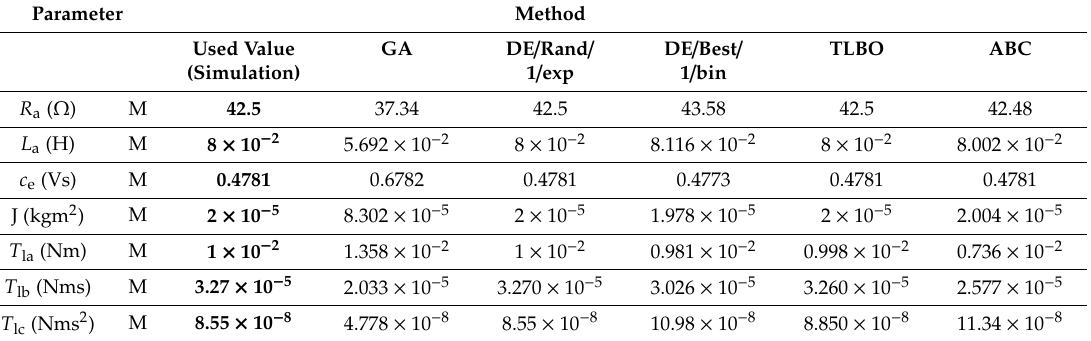
Table 6. Mean values of calculated parameters for